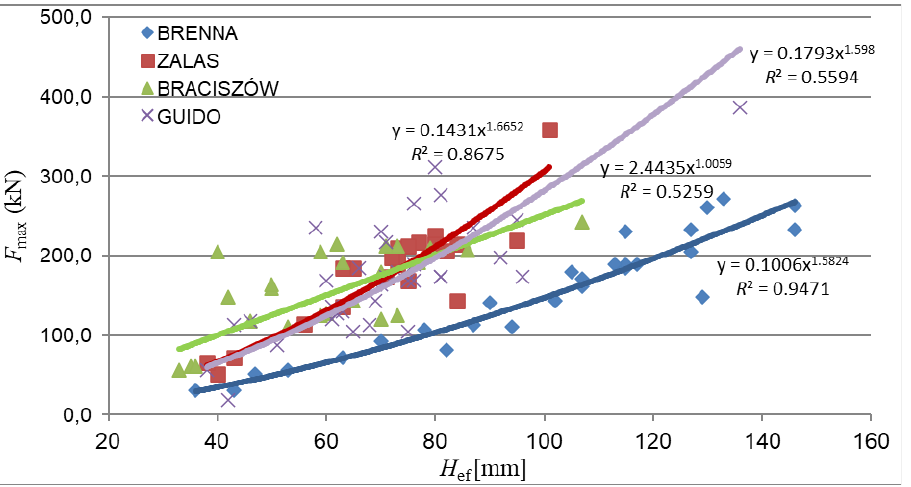
in relation to the effective anchoring depth H max